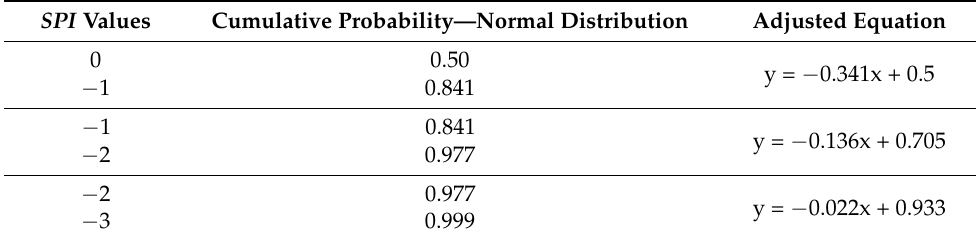
Table 2. SPI indicator